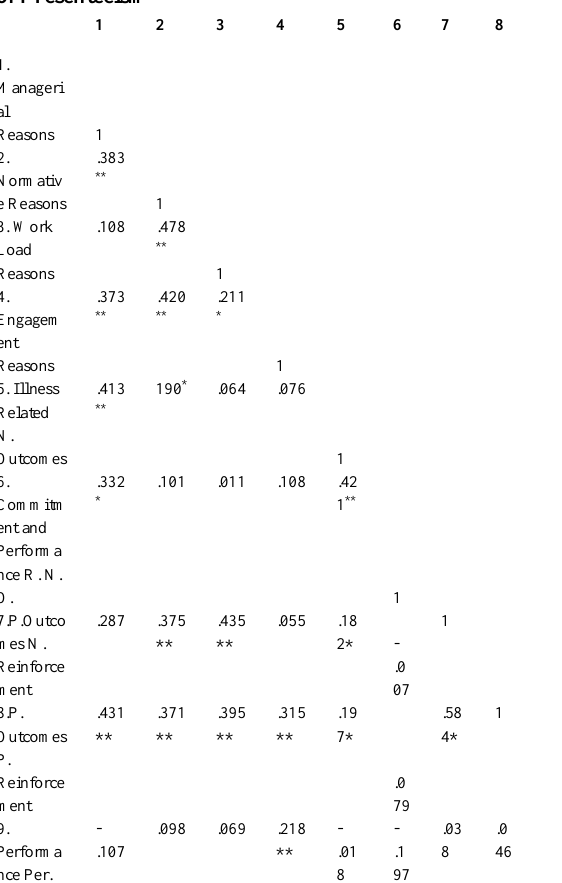
Table 15: Correlations among Reasons and Outcomes of Presenteeism